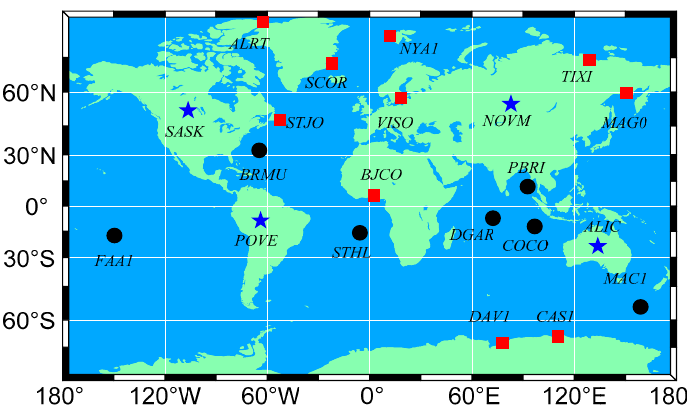
Figure 1. The distribution of the global navigation satellite system (GNSS) stations: four inland sites (blue star), seven island sites (black points), and ten coastal sites (red squares).